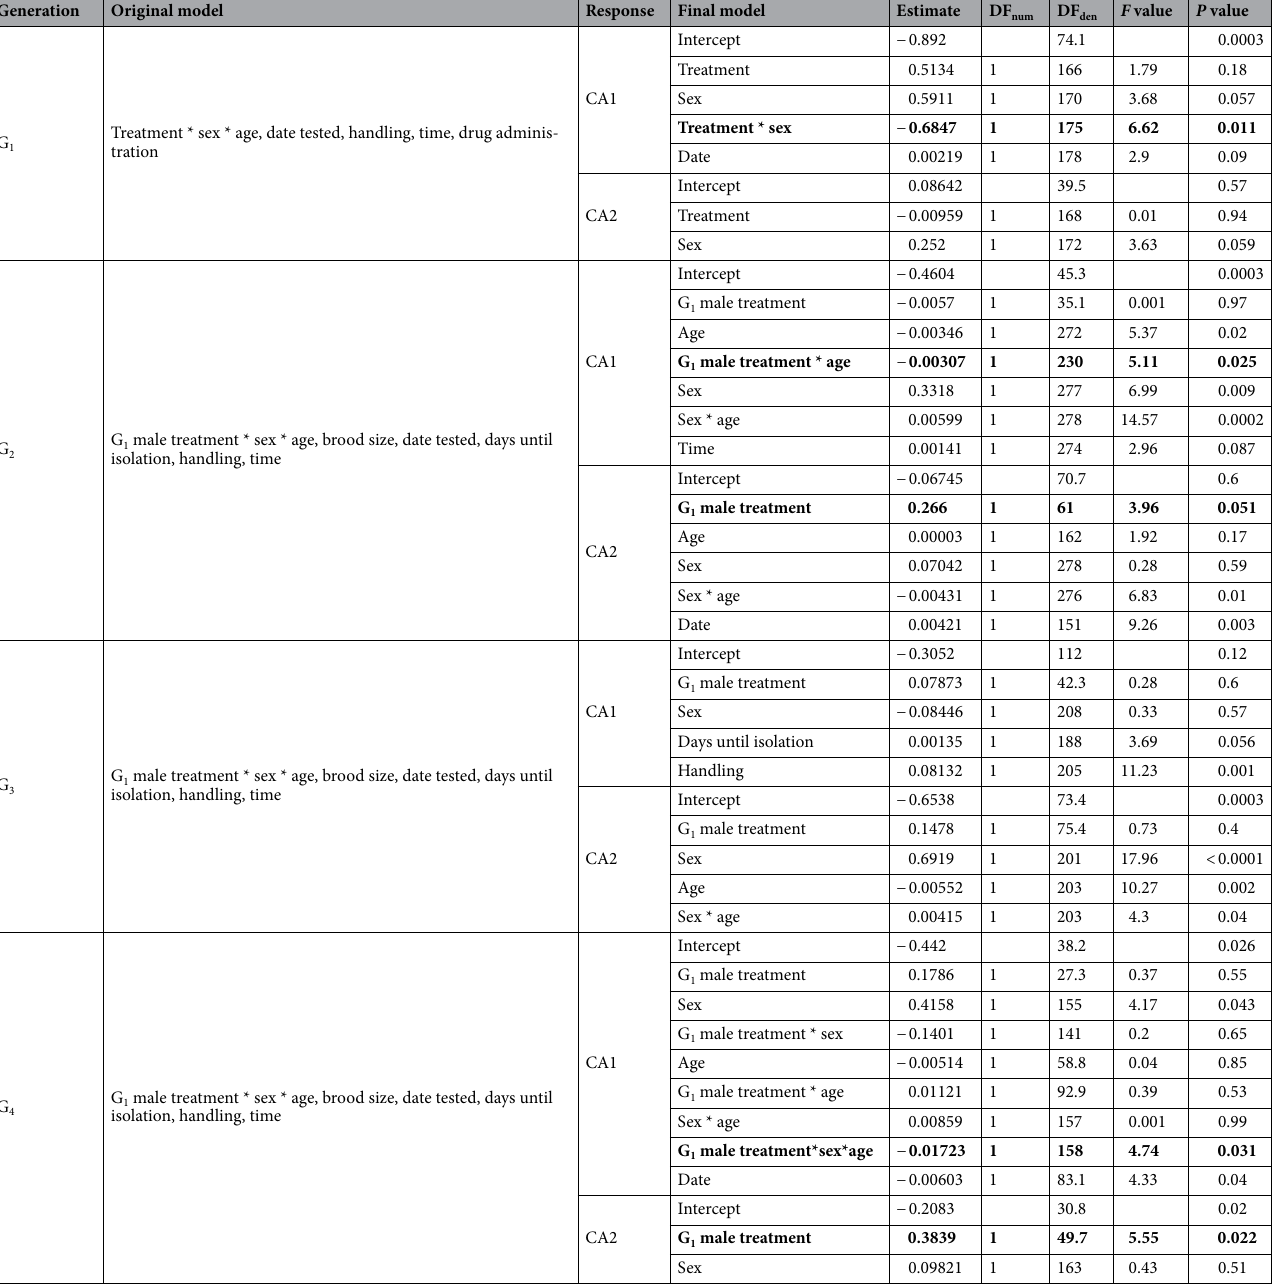
Table 1. Final results of mixed model analyses of G 1 –G 4 open field trials for CA1 and CA2. *Bolded text indicates that the model term ‘G 1 male treatment’ or interactions involving this term are statistically significant at P <